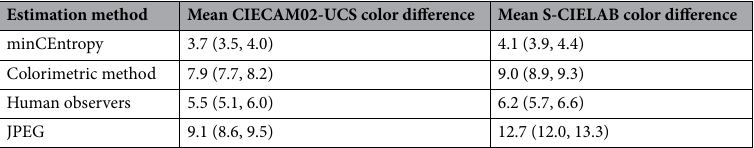
Table 4. Color rendering by relevant colors in two color spaces 17,41,42 . Color differences between the original image and its quantized representation are shown for minCEntropy clustering, the colorimetric method, six human observers, and JPEG, with values averaged over the 20 images. Estimated 95% BCa confidence limits 36 are shown in parentheses based on 1000 bootstrap